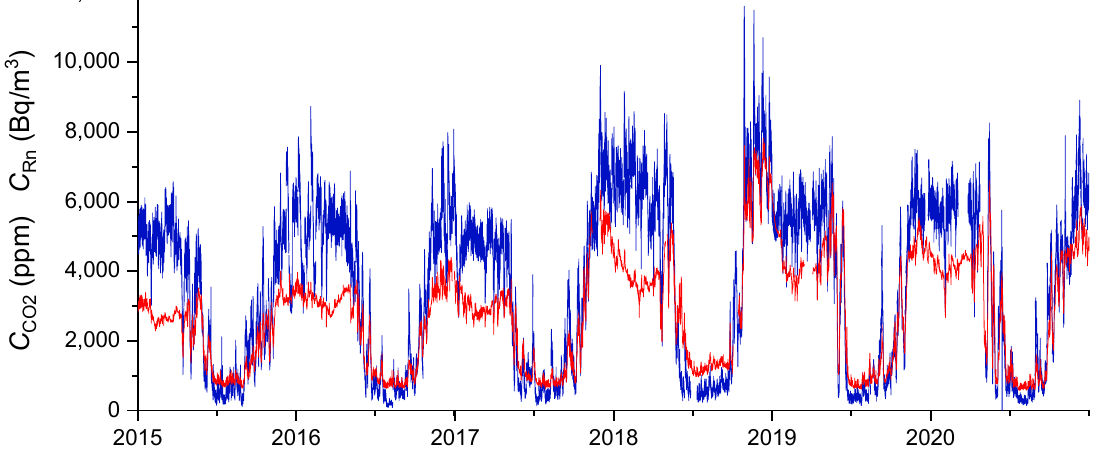
Figure 3. Time series of radon concentration (blue) and of CO 2 (red) in the Polychrome Room from 2015 to 2020.